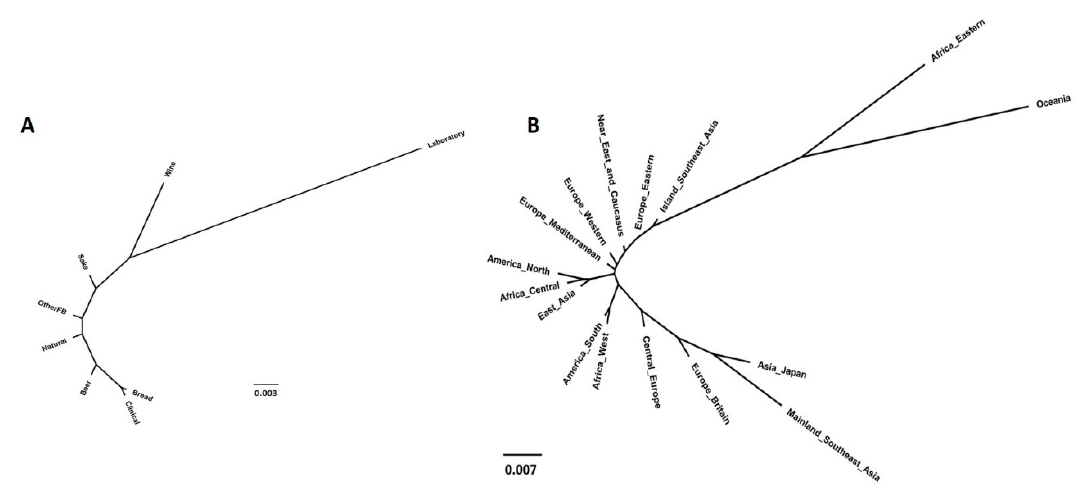
Figure 7. Population structure of Saccharomyces cerevisiae obtained using the neighbor-joining tree estimated from the matrix of Fst values computed by comparing groups of strains according to their technological applications ( A ) and geographical origins ( B ).